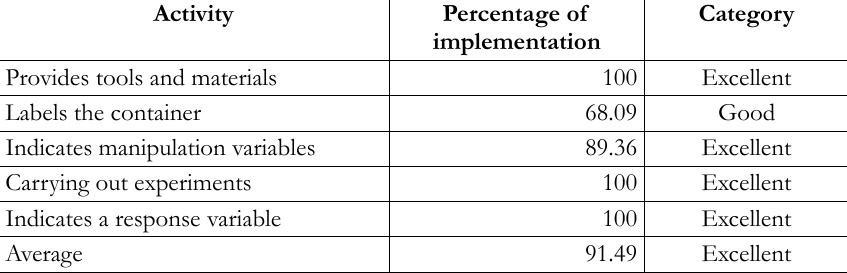
Table 7. Observation Data on Implementation of the